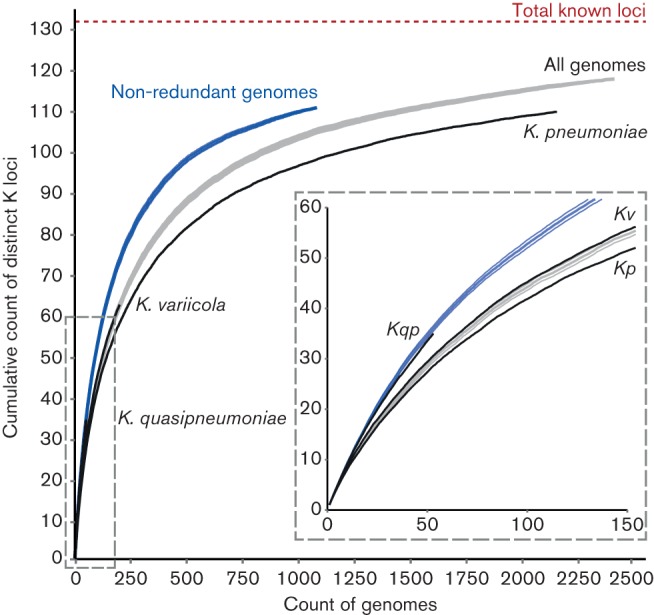
Rate of discovery of distinct K-loci with increasing genome sample size. Curves indicate the accumulation of distinct K-loci (mean±se) in different genome sets: grey, all genomes (n=2410, excluding K. oxytoca); blue, non-redundant genomes (n=1081, excludes genomes from investigations of disease outbreaks and specific clonal groups); black, species-specific genome sets (K. pneumoniae refers to K. pneumoniae sensu stricto, se not shown). The inset shows a magnified view of the bottom-left section of the plot, as indicated by the dashed box.